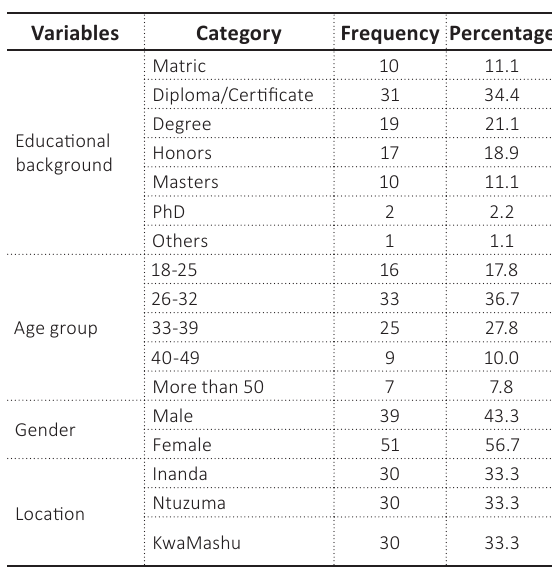
Table 2. Demographic information of surveyed social